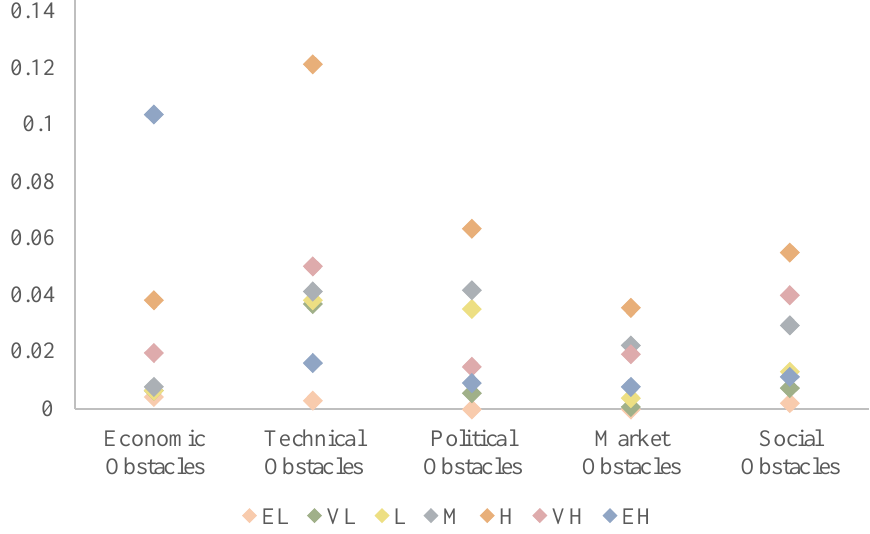
Figure 5. The distribution of membership degree.